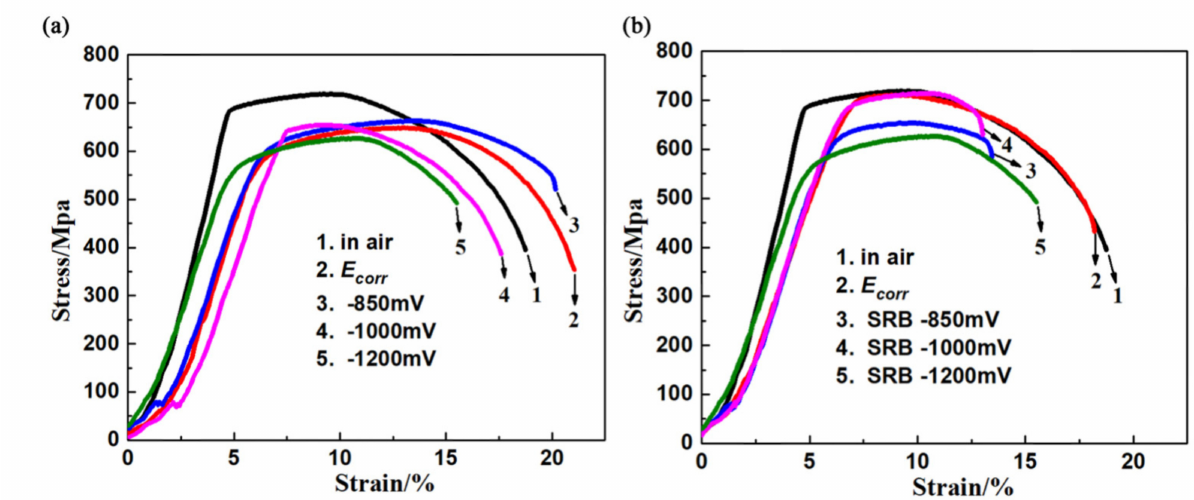
Figure 2. Engineering stress–strain curves of X80 steel in high-pH solution under different conditions: ( a ) without SRB; ( b ) with SRB.